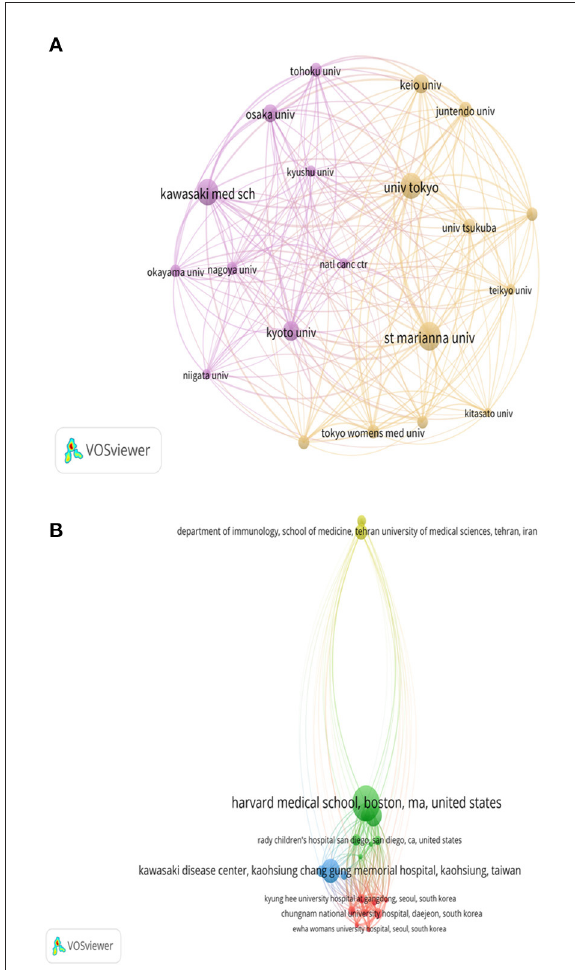
FIGURE4 Collaboration networks between the most prominent research institutions in KD research: (A) WOS and (B) Scopus. Different colors belong to different clusters and the area of the dots is proportional to the inter-institutional